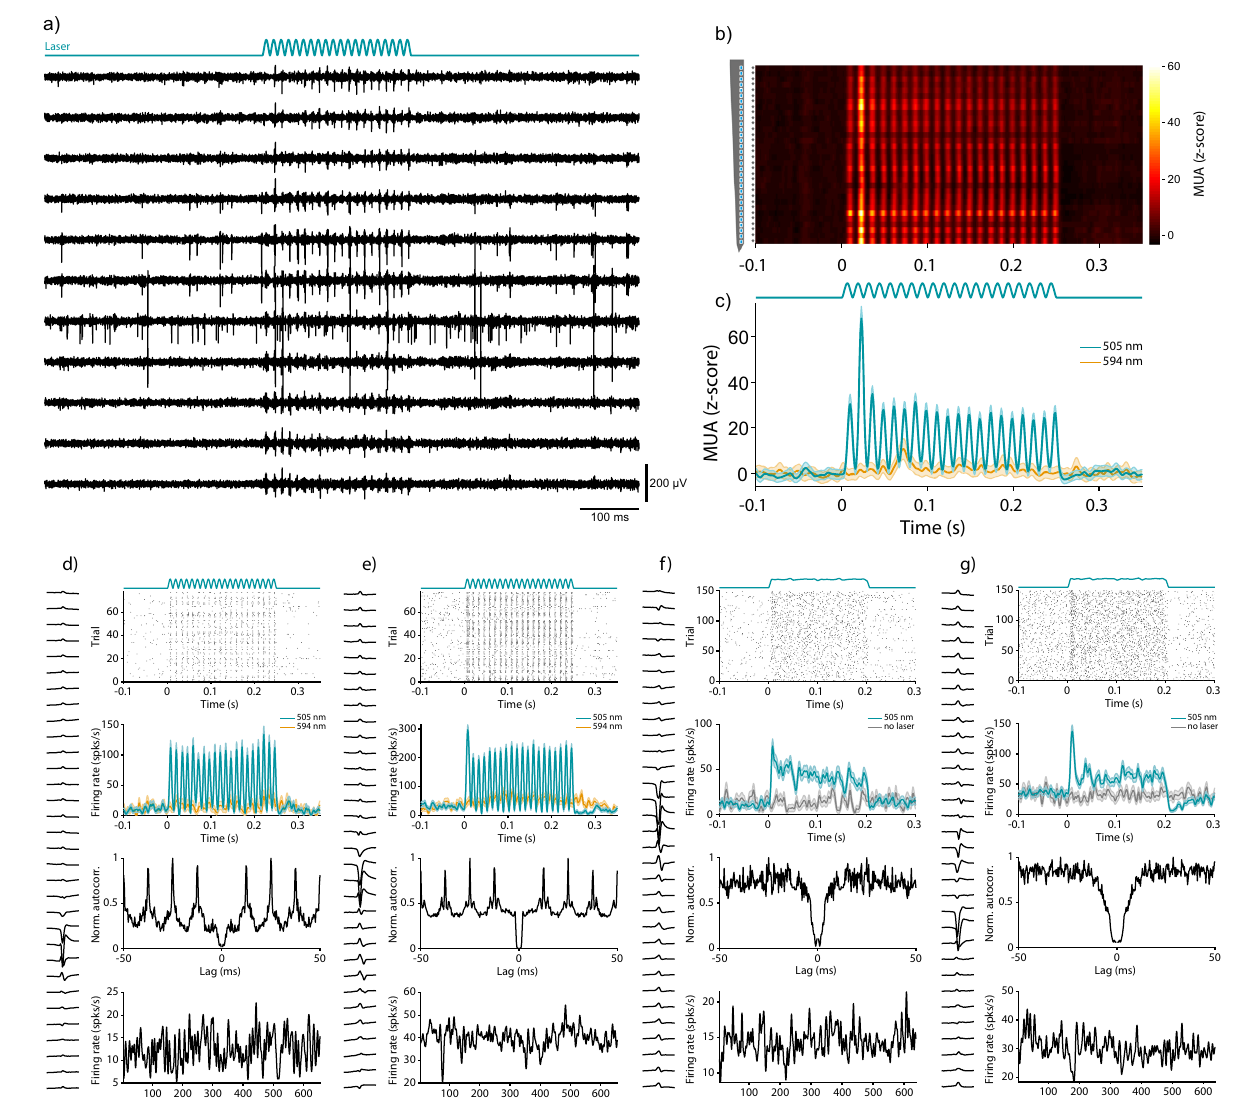
Fig. 7 | Optogenetic activation of neurons in the awake marmoset. a Example traces of band-pass- fi ltered data during optogenetic stimulation with an 80Hz sinusoidal pattern of 250ms duration (25mW peak). b Trial-averaged, z-scored MUA of all recording sites from an example shank for the 505nm stimulation condition. Asterisks on the left indicate signi fi cantmodulation( P <0.05, two-sided Kolmogorov – Smirnov test for channels with MUA>3 σ ) between pre-stimulation baseline window ( − 25 to 0ms) and the stimulus window (0 to 25ms after laser onset;thestimuluswindowwaschosentobeshortinordertoexcluderesponsesto visual stimuli present in some trials). c Average MUA±SEM across all signi fi cantly modulated channels ( n =32 out of 32 channels), for stimulation with 505nm and 594nm, respectively as indicated by the color legend. Note that the 594nm con- dition included a subset of trials with visual stimulation, which explains the tran- siently enhanced MUA around 70ms post laser onset. d – g Four examples of optogenetically modulated single units: d , e from Monkey A, f and g from Monkey